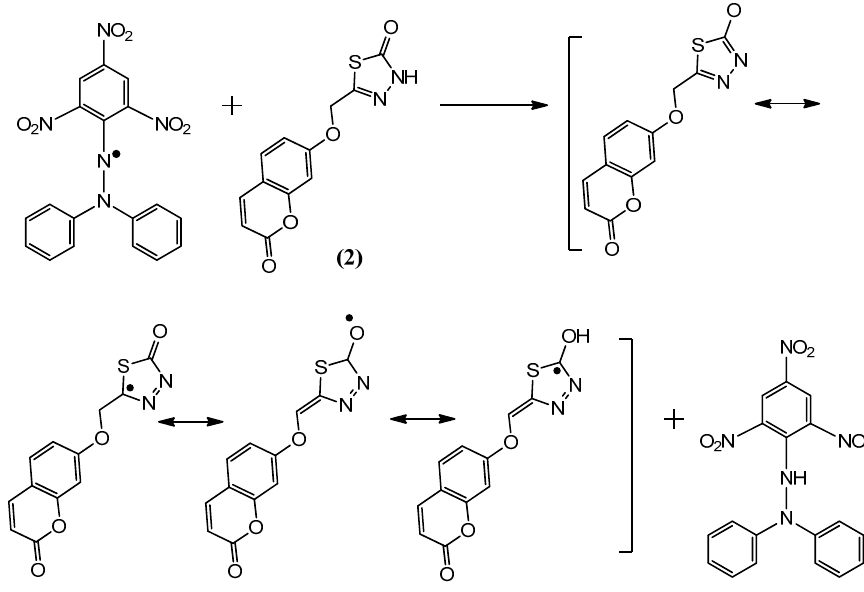
Figure 4. The reaction scheme between DPPH free radicals and compound 2 .